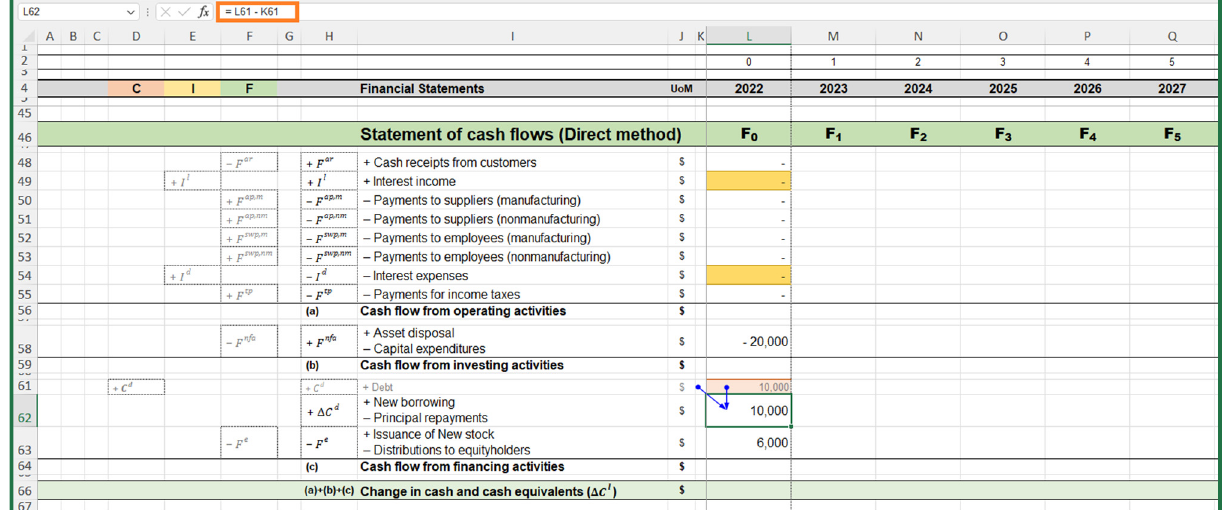
as the difference between 0